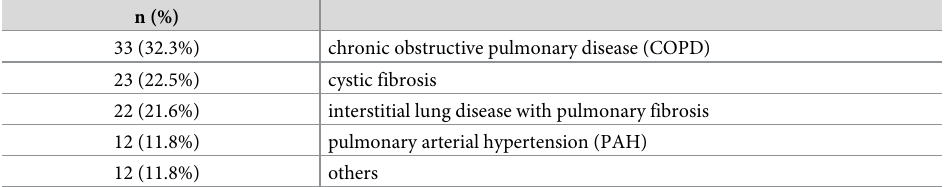
Table 3. Indications for lung